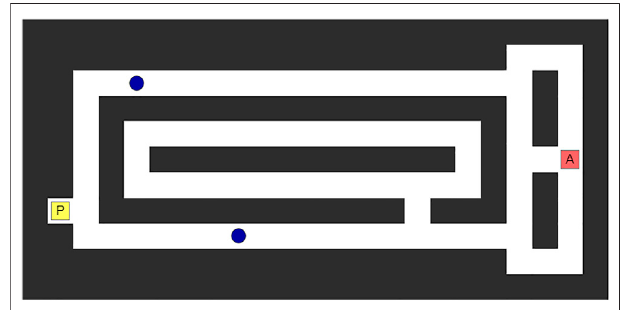
FIGURE 3 | Example of